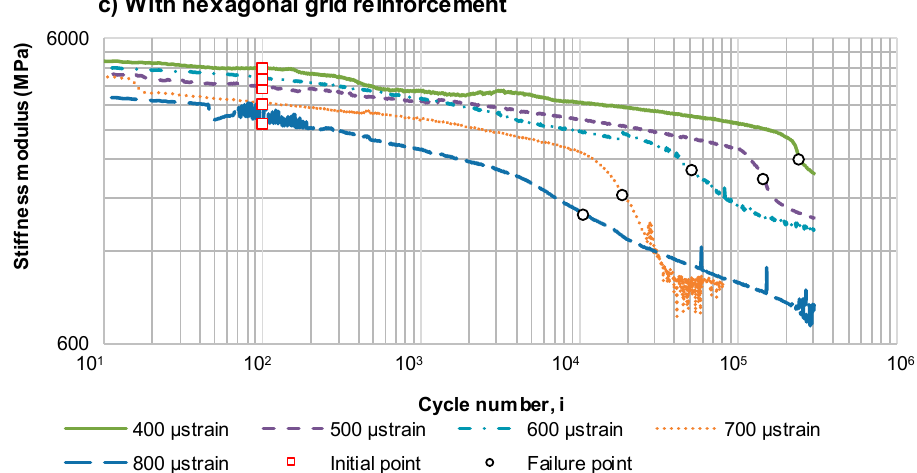
Figure 10. The change in stiffness modulus of double-layered asphalt beams: ( a ) without reinforcement, ( b ) with square grid reinforcement and ( c ) with hexagonal grid reinforcement.